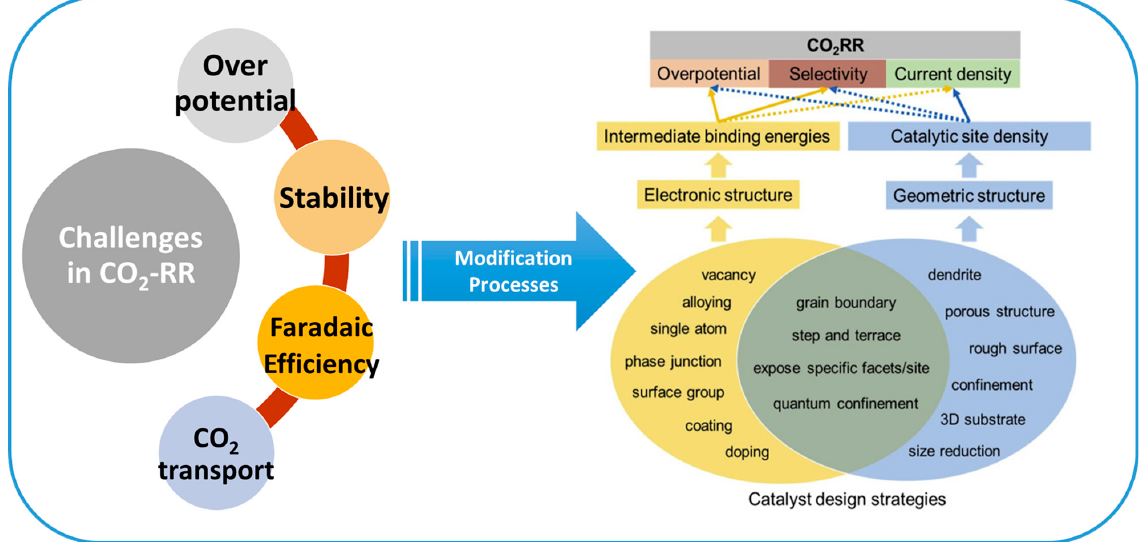
Figure 4. Schematic illustration of practical challenges and factors affecting CO 2 electroreduction (ER-CO 2 ) [5] (copyright: Elsevier, 2020).